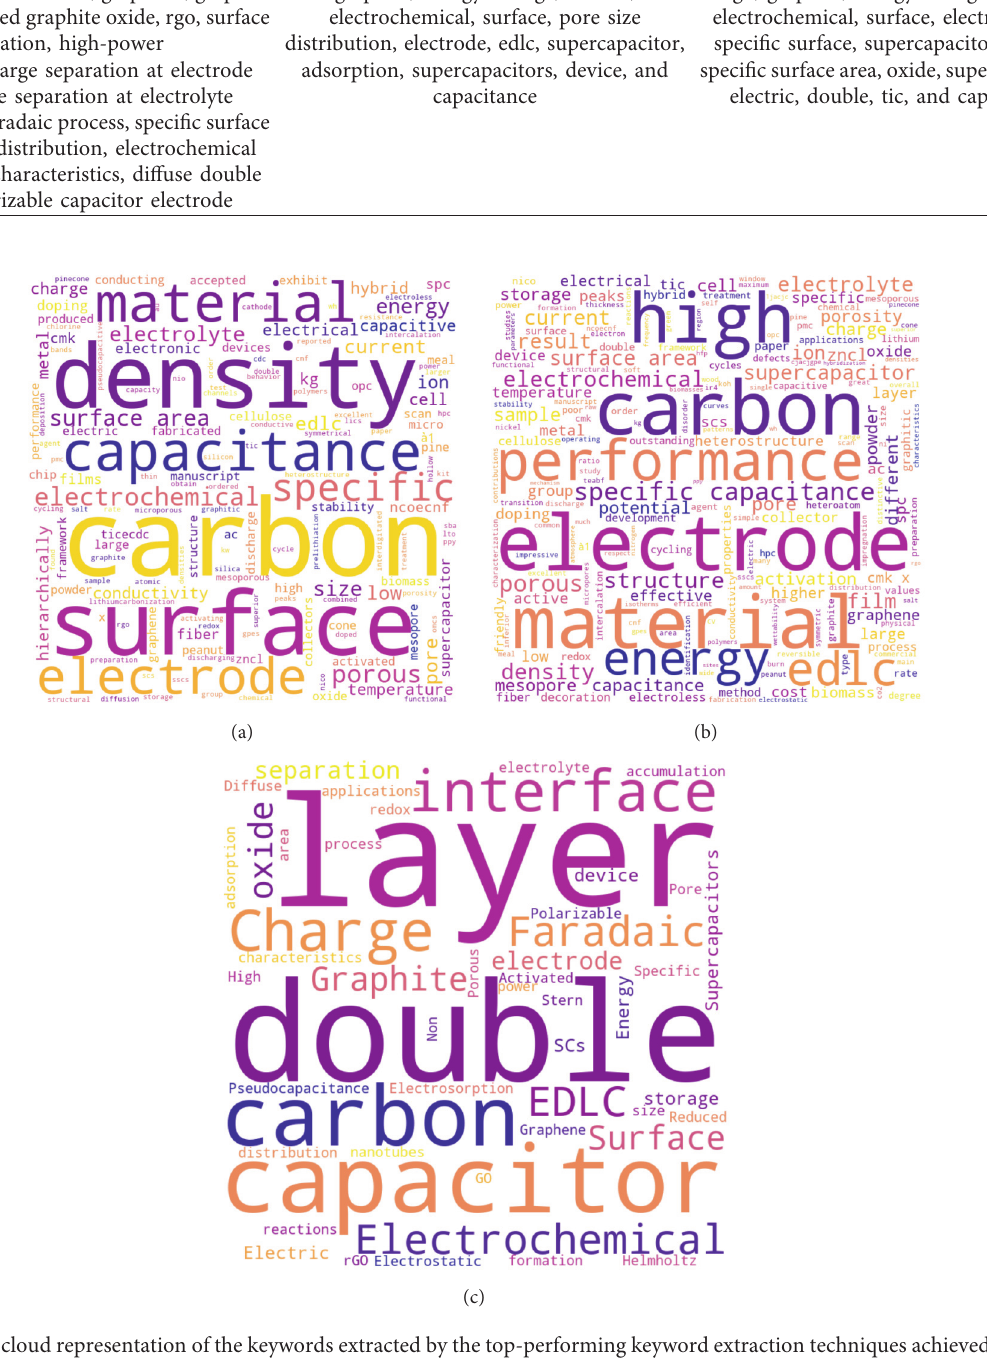
Figure 6: Word cloud representation of the keywords extracted by the top-performing keyword extraction techniques achieved with cosine with Word vector similarity index. (a) Word cloud of the keywords extracted by supervised. (b) Word cloud of the keywords extracted